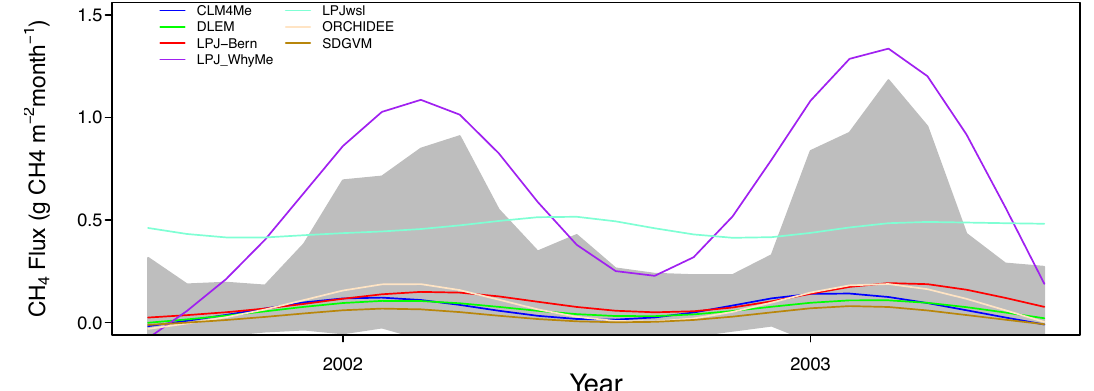
Figure 8. Mean monthly net CH 4 flux for the Alaskan Arctic (North Slope), showing two years for example (2002–2003). The gray area is the multi-model standard deviation.